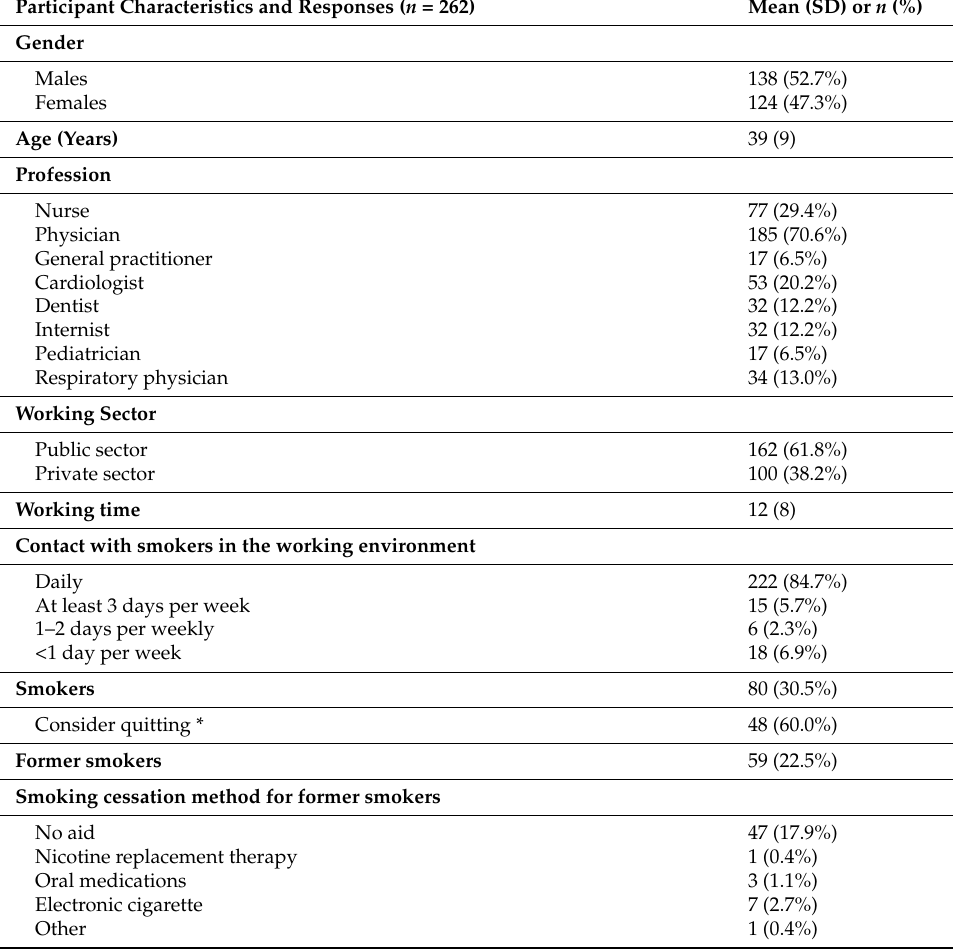
Table 1. Characteristics and responses of all survey